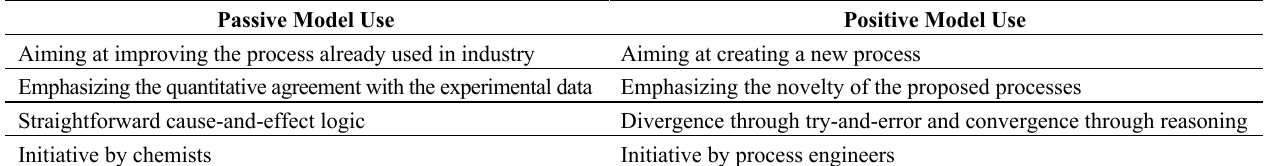
Table 4. Positive model use proposed in this